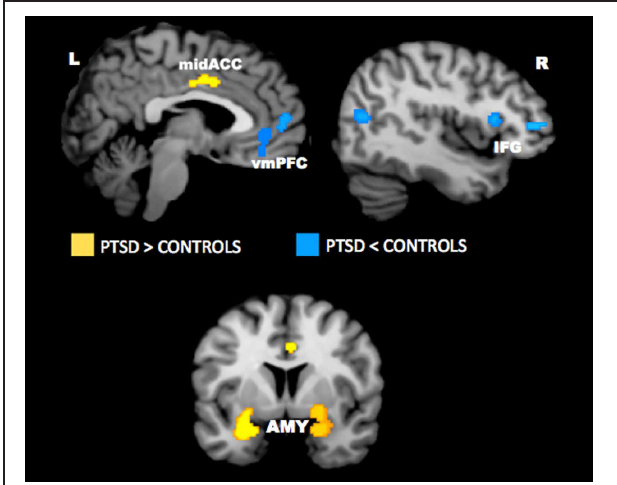
FIGURE 4 | Meta-analysis of functional neuroimaging studies in PTSD. Across various task designs, the amygdala and mid-ACC are hyperactive in PTSD whereas the lateral and medial prefrontal cortex are hypoactive for negative emotional stimuli vs. neutral and positive stimuli. Areas of hyperactivation in PTSD (PTSD > Control) are shown in yellow and areas of hypoactivation in PTSD (Control > PTSD) are shown in blue. AMY = amygdala, IFG = inferior frontal gyrus, L = left, mid-ACC = mid anterior cingulate cortex, R = right, vmPFC = ventromedial prefrontal cortex. Reproduced from Hayes et al.